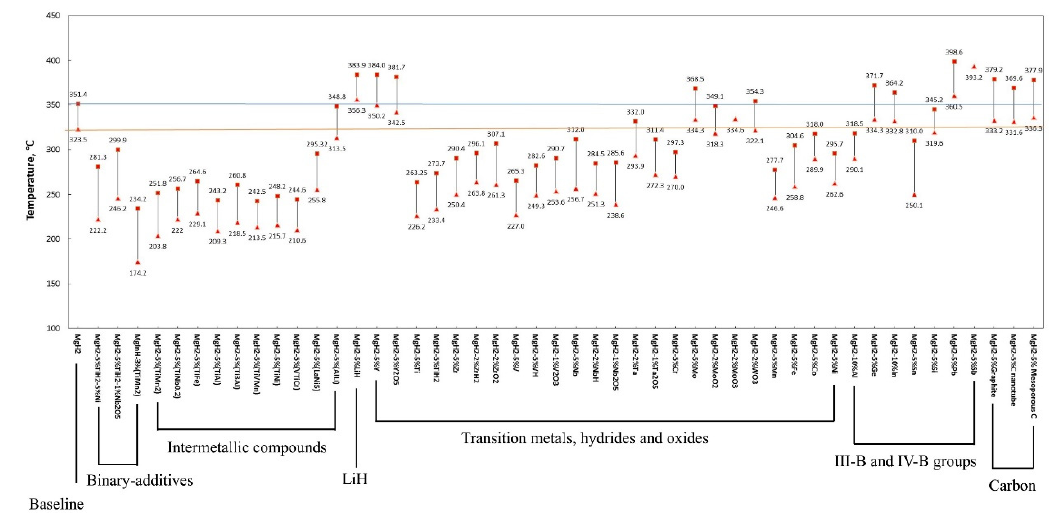
Figure 8. Effect of various additives on dehydrogenation temperatures of MgH 2 . (Reprinted with permission from ref. [90]. Copyright 2015 Elsevier.).